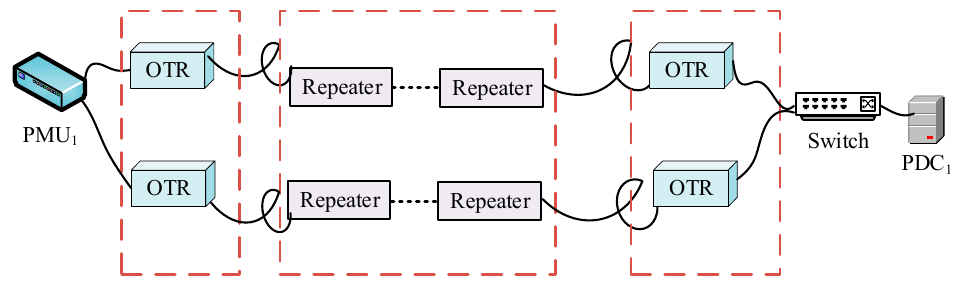
Figure 5. Simplified reliable dedicated SCN.